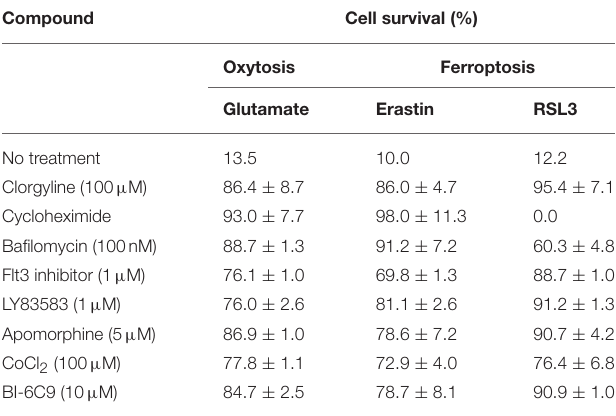
TABLE 1 | Oxytosis and ferroptosis show an identical pharmacological profile. Compound Cell survival